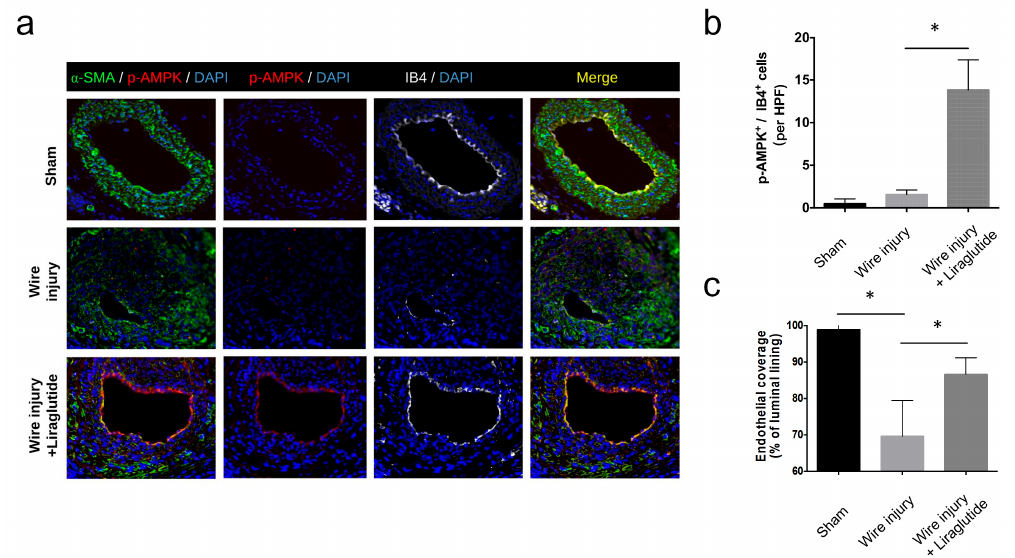
Figure 7. Liraglutide activates AMPK and enhances endothelial recovery in vivo. ( a ) STZ-induced diabetic C57BL/6 mice were subjected to a wire-induced carotid artery injury with or without liraglutide treatment. The expression of α -SMA (green) and p-AMPK (red) in the carotid arteries was analyzed by immunofluorescence staining. The endothelium was labelled by isolectin B4 (IB4, grey). Nuclei were stained with DAPI. ( b ) Number of p-AMPK + IB4 + endothelial cells per high-power field (HPF). ( c ) Percentage of endothelial coverage of the vascular lumen. Data are shown as mean ± SD, from three independent experiments. * P < 0.05. The statistical significance was assessed by Kruskal–Wallis test.